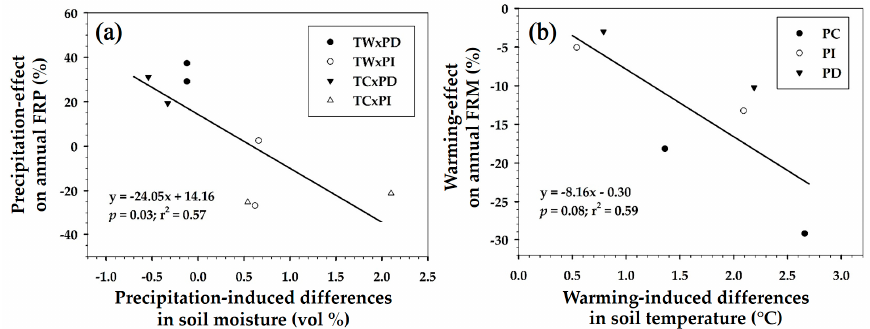
Figure 1. ( a ) Linear regression between precipitation-effect on annual fine root length production (FRP) of Pinus densiflora seedlings and precipitation-induced differences in soil moisture; ( b ) between warming-effect on annual fine root length mortality (FRM) and warming-induced differences in soil temperature. The treatment abbreviations are the same as in Table 2.